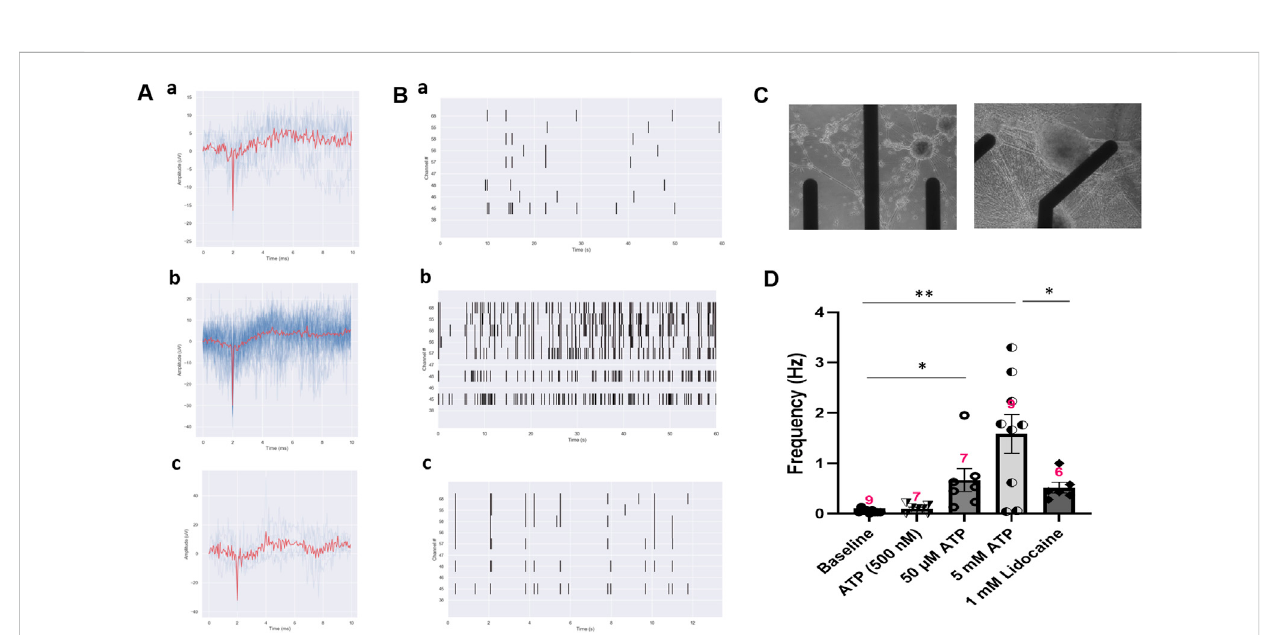
FIGURE 5 Activity of iPSC-nociceptors recorded on MEAs. (A) Representative MEA action potential responses of iPSC-nociceptors demonstrating the excitation effect of ATP. a) baseline activity, b) activity after addition of ATP (5 mM) and c) activity after the subsequent addition of lidocaine (1 mM). (B) Rasterplotdemonstratingthechangeofneuralactivityasdescribedin (A) . (C) PhaseimagesoftheelectrodewithiPSCnociceptorsplatedonanMEA. (D) Graphoftheneural fi ringfrequencyasdescribedin (A) .DatapresentedareMean+StandardError.One-wayANOVA,* < 0.05;** < 0.005.Numberof biological replicates from at least three batches of experiments were indicated in each data bar in the